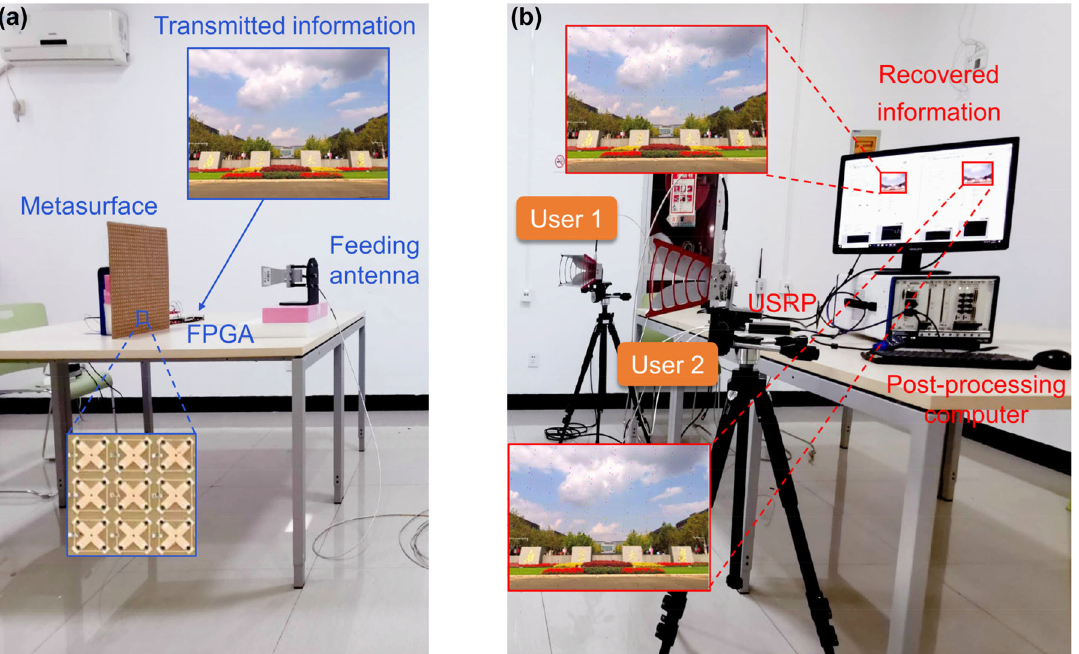
Figure 3: Experimental scenario of the metasurface-based wireless communication system. (a) Transmitting terminal. Insets illustrate the transmitted information and a zoom-in view of the fabricated sample. (b) Receiving terminal. Insets illustrate the recovered information at the two user terminals at 4.6 GHz when binary symbols “0” and “1” are fixed to spatial patterns of “R